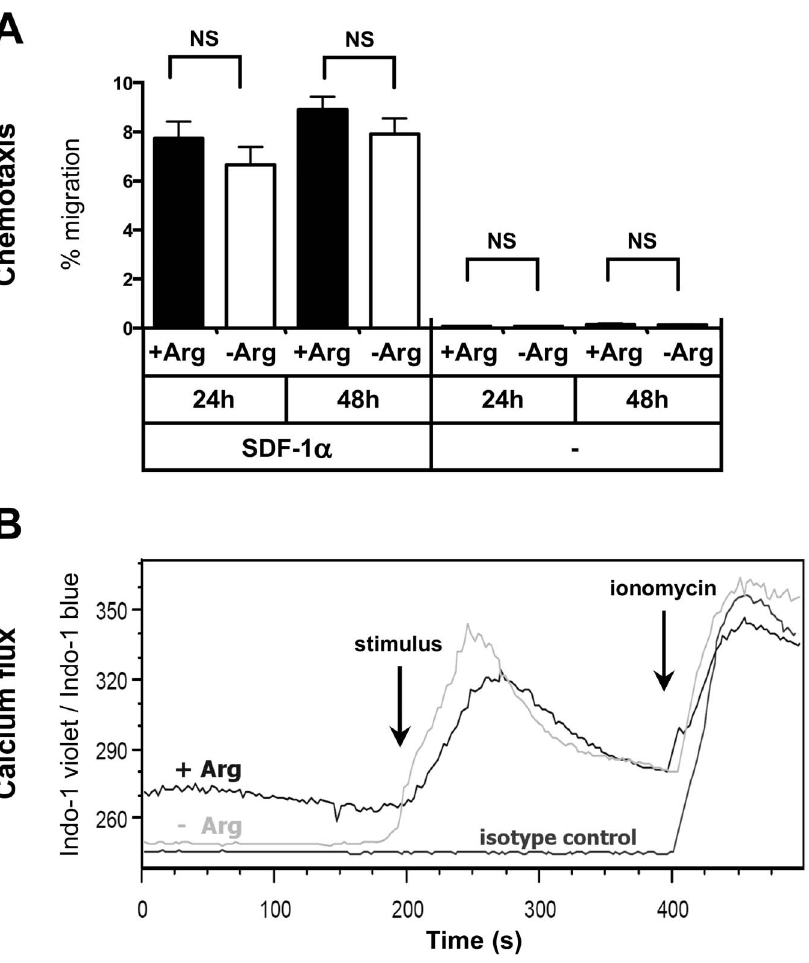
Figure 1. Arginine-independent T cell functions: chemotaxis and calcium flux. A Purified primary human T cells were preincubated either for 24 h or 48 h in the presence ( + Arg, 1000 m M) or absence ( 2 Arg, 0 m M) of arginine. They were then placed in the respective media into the upper compartment of a trans-well plate, whereas a chemokine (SDF-1 a ) was added to the lower compartment of the well. Wells without chemokine were also set up to detect spontaneous migration of cells. Maximum migration was determined by adding the same number of T cells to the lower compartment of a separate well. After 4 h cells in the lower compartment were quantified flow-cytometrically. Migration of T cells (%) was calculated relatively to the maximum migration which was set to 100%. Shown are summarized mean values and standard deviations of results from 3 individual experiments. NS: not significant. B Calcium signaling in primary human T cells in the presence ( + Arg, 1000 m M) or absence ( 2 Arg) of arginine was analyzed by flow cytometry using the calcium indicating dye Indo 1-AM. The ratio of Indo-1 violet/Indo-1 blue correlates directly with the amount of calcium in the cell. T cells were preincubated with OKT-3 antibody and calcium levels of resting cells were monitored for 3 min. The cells were then stimulated by adding a crosslinking antibody (=stimulus), which led to increasing calcium levels irrespective of arginine. As a negative control, isotype control antibody was used instead of OKT-3. Finally, the calcium ionophore ionomycin was added as a positive control. One representative analysis (total number of experiments=3) is shown as a histogram plot